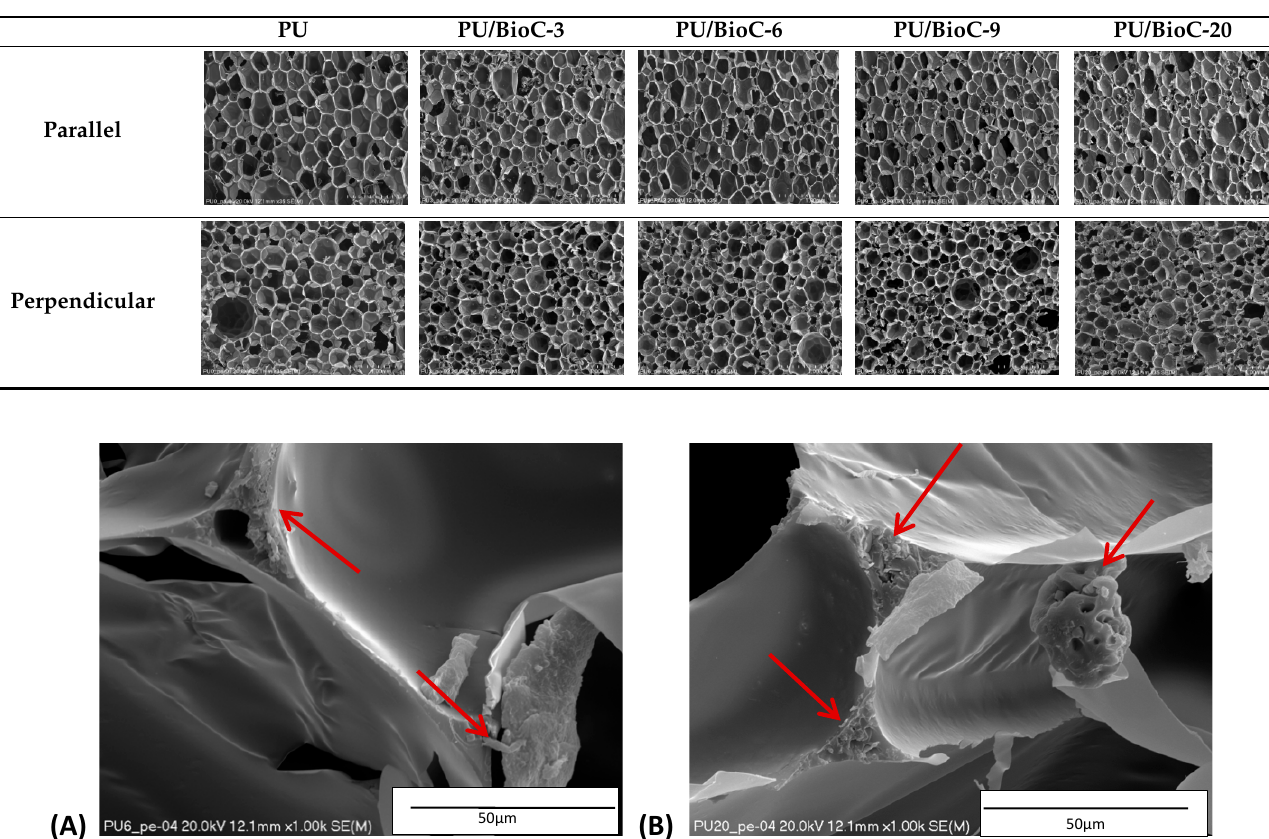
Table 3. SEM microphotographs of foams.